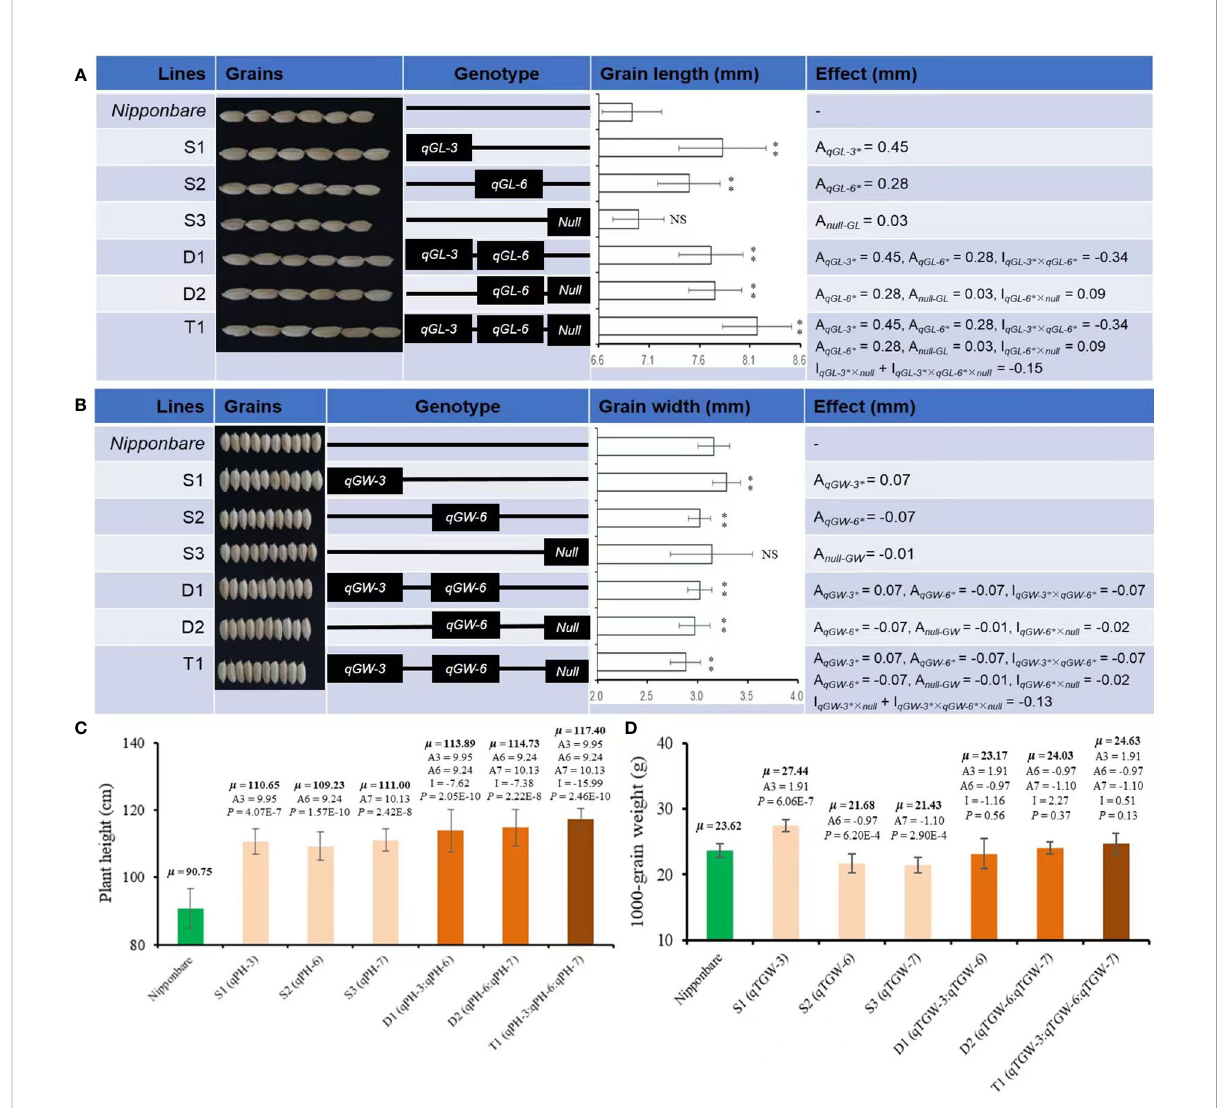
FIGURE 4 Phenotypes and estimated effects of QTLs for GL, GW, PH, and TGW among Nipponbare and the screened CSSLs. (A) Grain length (mm), (B) Grain width (mm), (C) Plant height (cm), (D) 1000-grain weight (g). m : the average phenotypic value, a: denotes the additive effect of QTLs, i: denotes the additive × additive epistatic effect among QTLs. **, signi fi cant at.01 level ( P < .01); NS, not signi fi cant. The P -value for a SSSL indicates the probability of a signi fi cant difference between the SSSL and